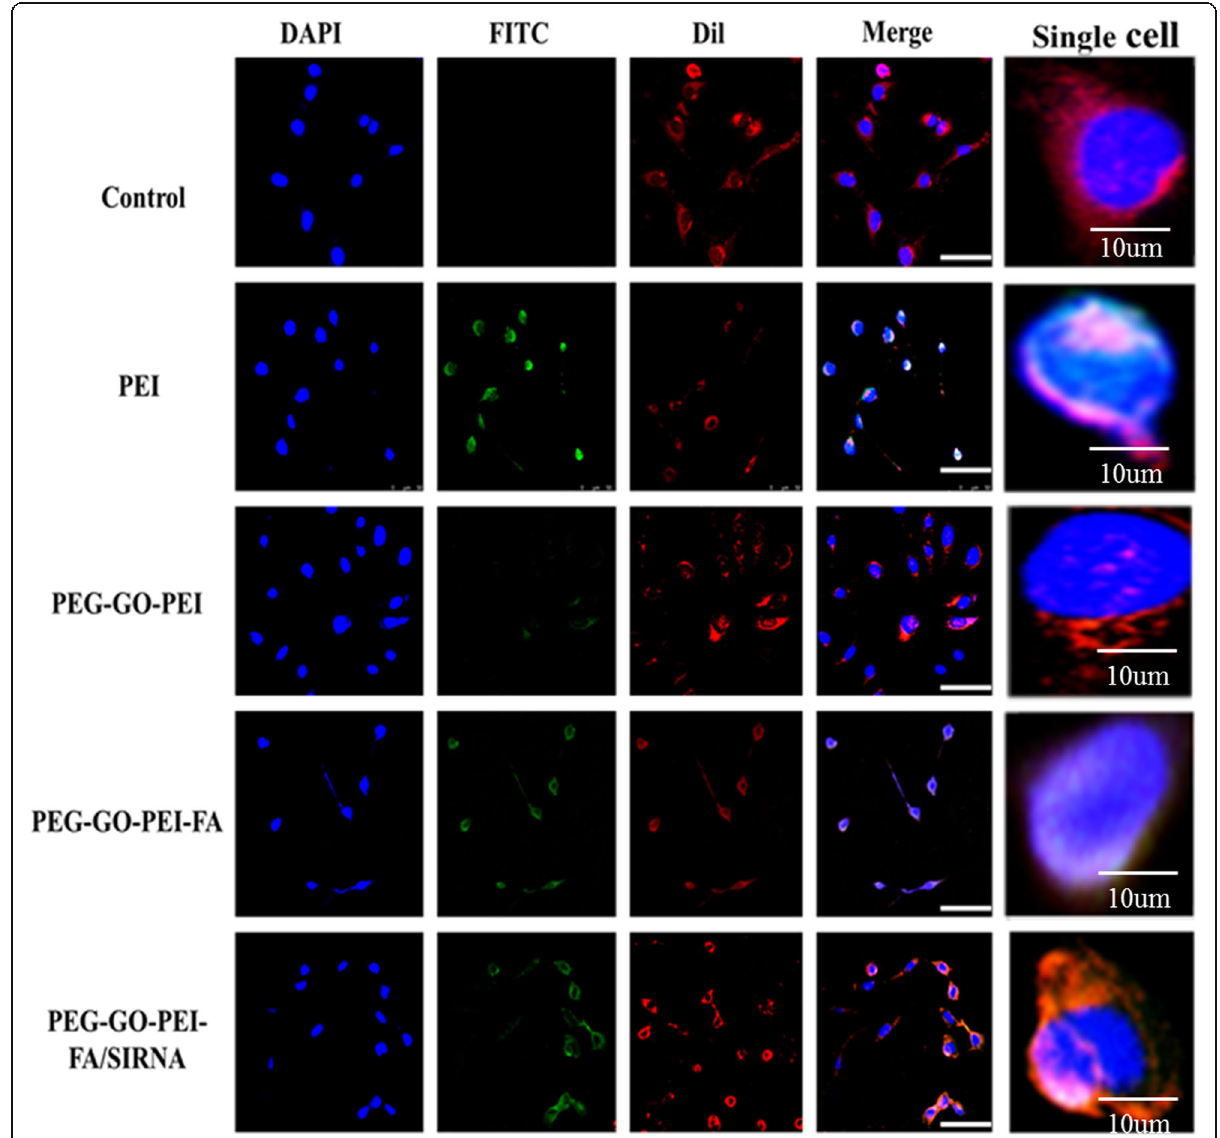
Fig. 4 Cellular uptake of different nanocomplexes. Confocal laser scanning microscopy (CLSM) images of the cellular uptake of FITC-labeled different nanocomplexes in human ovarian cancer SKOV3 cells after incubation for 4 h. Blue, nuclei (DAPI-labeled); red, cytomembrane (Dil- labeled); green, nanocomplexes (FITC-labeled). Scale bars represent 100 μ m, but the scale bar is 10 μ m in single